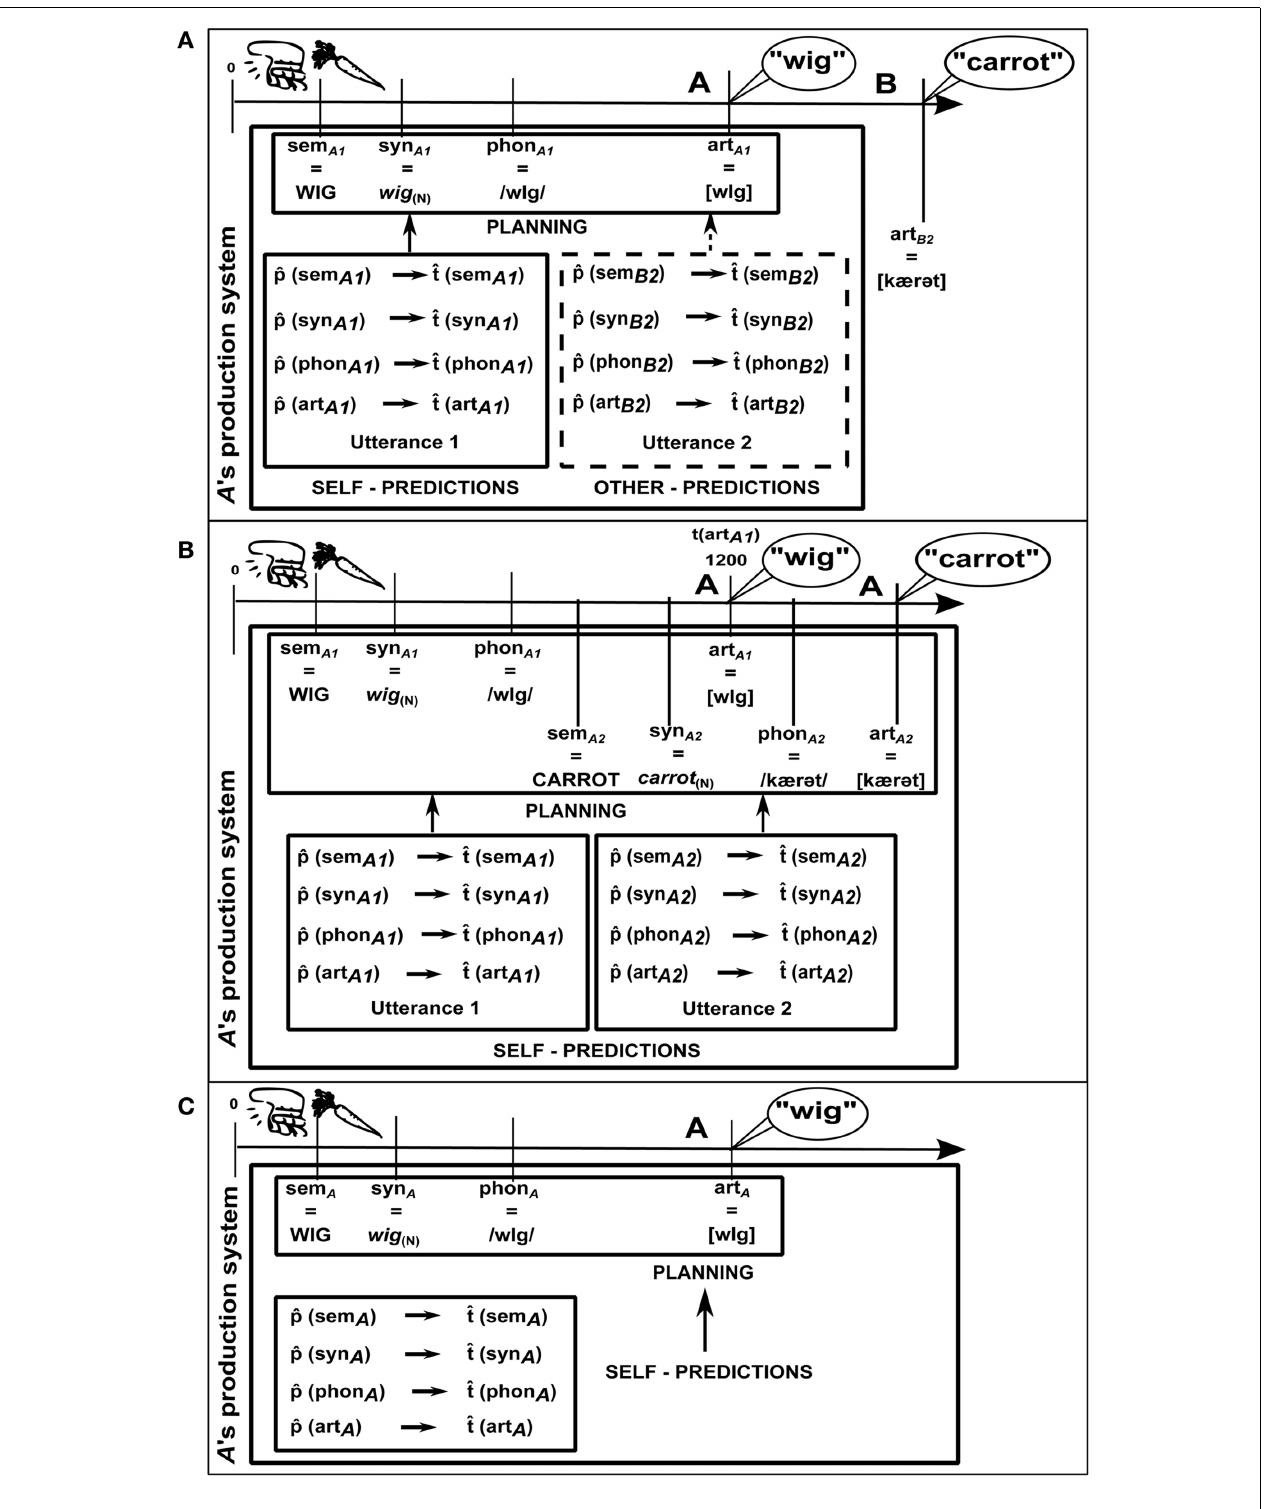
between them by way of number subscripts (1 for the first utterance, 2 for the second utterance). In (A) art B2 stands for the articulation stage of B ’s utterance and ˆ p (sem B2 ) is the semantic content prediction that A generates in relation to B ’s utterance.Time in ms. All other details as in Figure 1